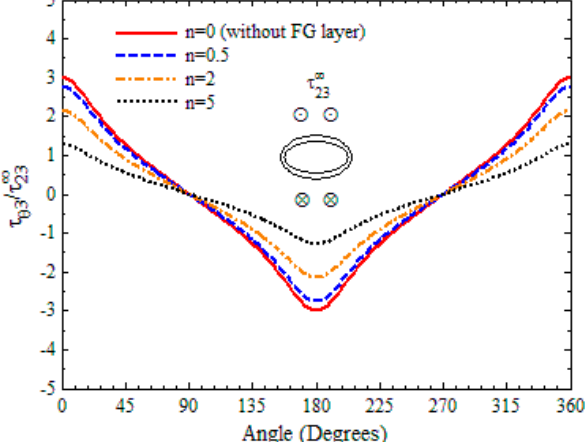
τ around the hole (ellipse). 3 θ